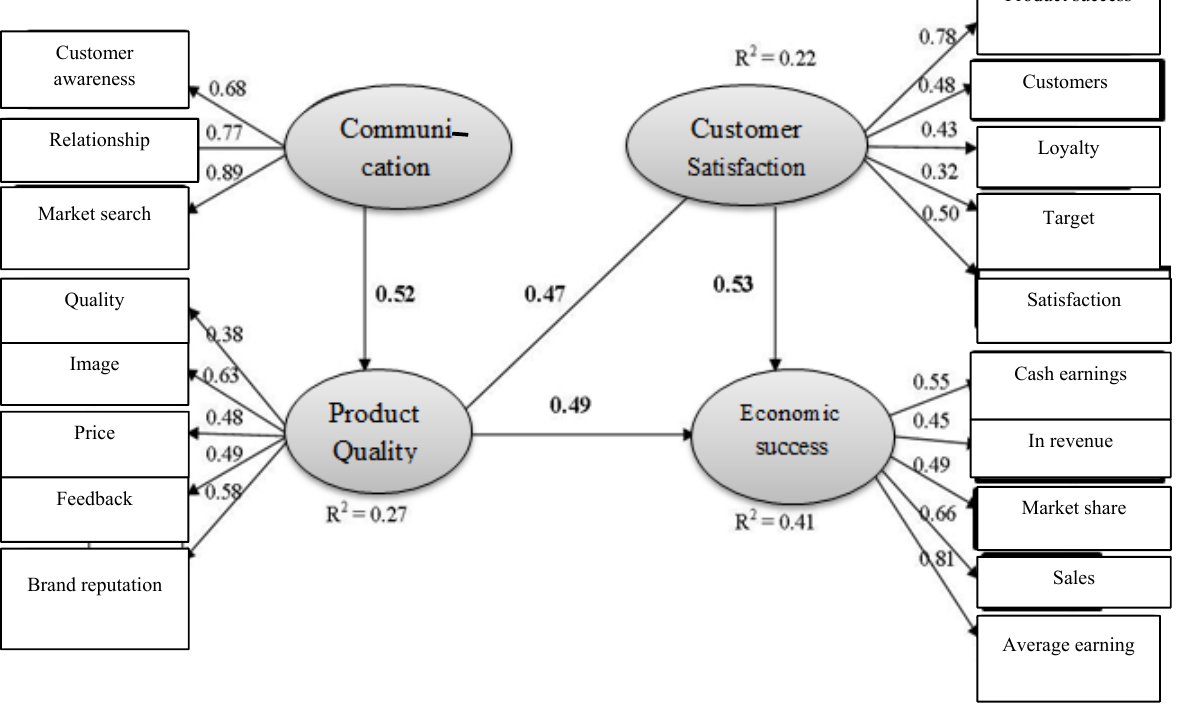
Fig. 2. The results of the SEM